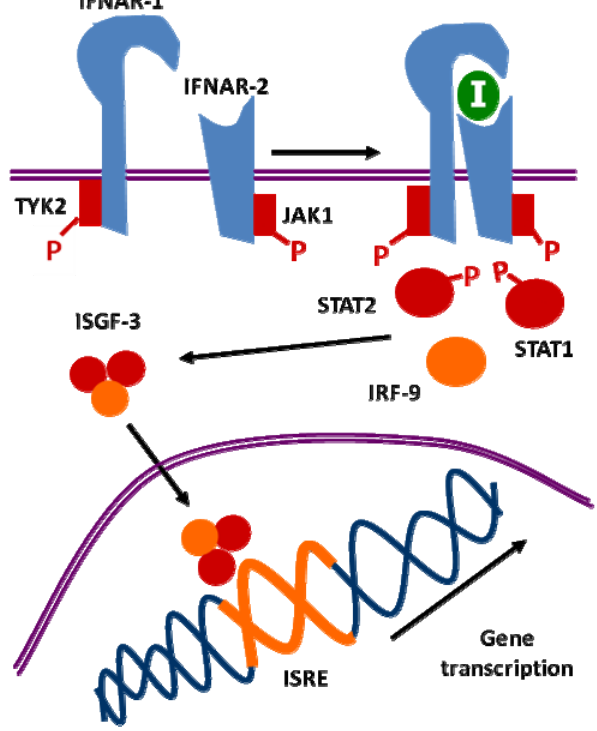
Figure 4. Induction mechanism of genes by type I interferons. IFNAR , IFN- α receptor; IRF , interferon regulatory factor; ISGF , IFN-stimulated gene factor; ISRE , interferon- stimulated response element; TYK , tyrosine kinase; JAK , Janus kinase; STAT , Signal Transduction and Activator of